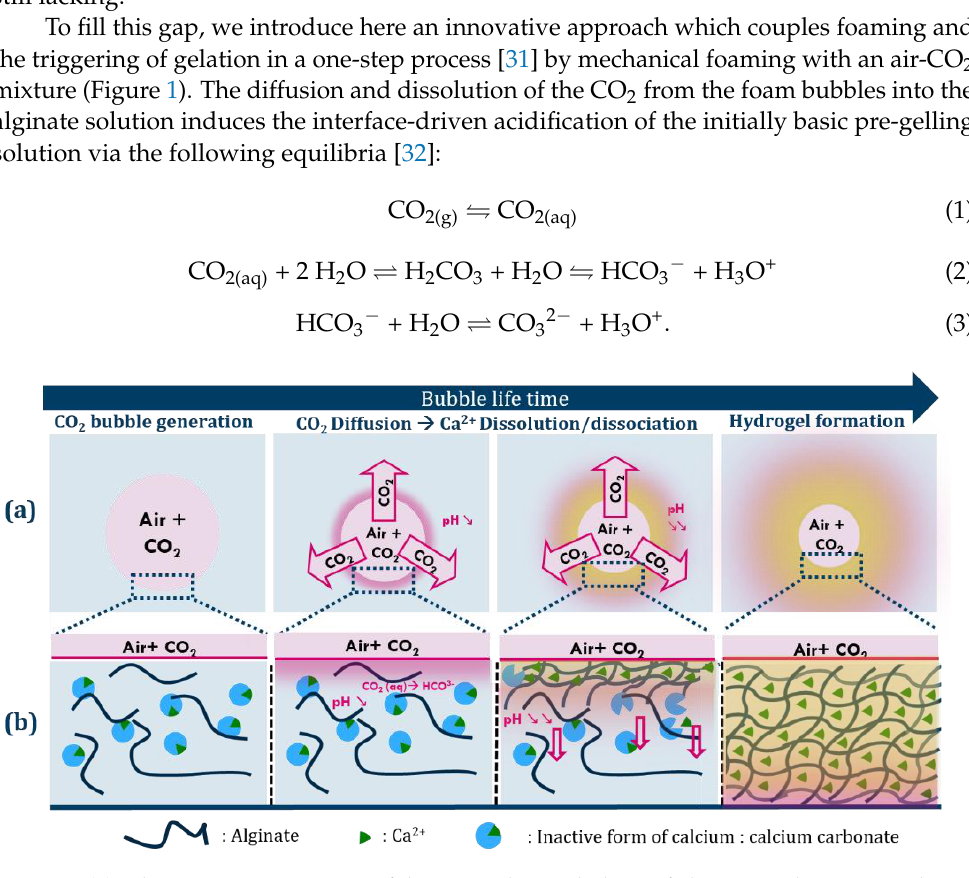
Figure 1. ( a ) Schematic representation of the internal cross-linking of alginate with inactive calcium ions (CaCO 3 ) via acidification of the medium induced by the dissolution of CO 2 from the bubbles. ( b ) Scheme of the diffusion of CO 2 from the interface into the bulk and evolution of the gelling front with time. The growing hydrogel layer is represented in yellow.